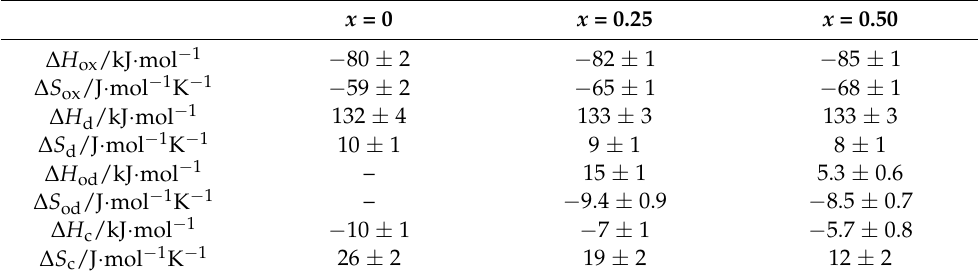
Table 1. Thermodynamic parameters of defect formation reactions in PrBa 1 − x Sr x Fe 2 O 6 − δ . x = 0 x = 0.25 x = 0.50